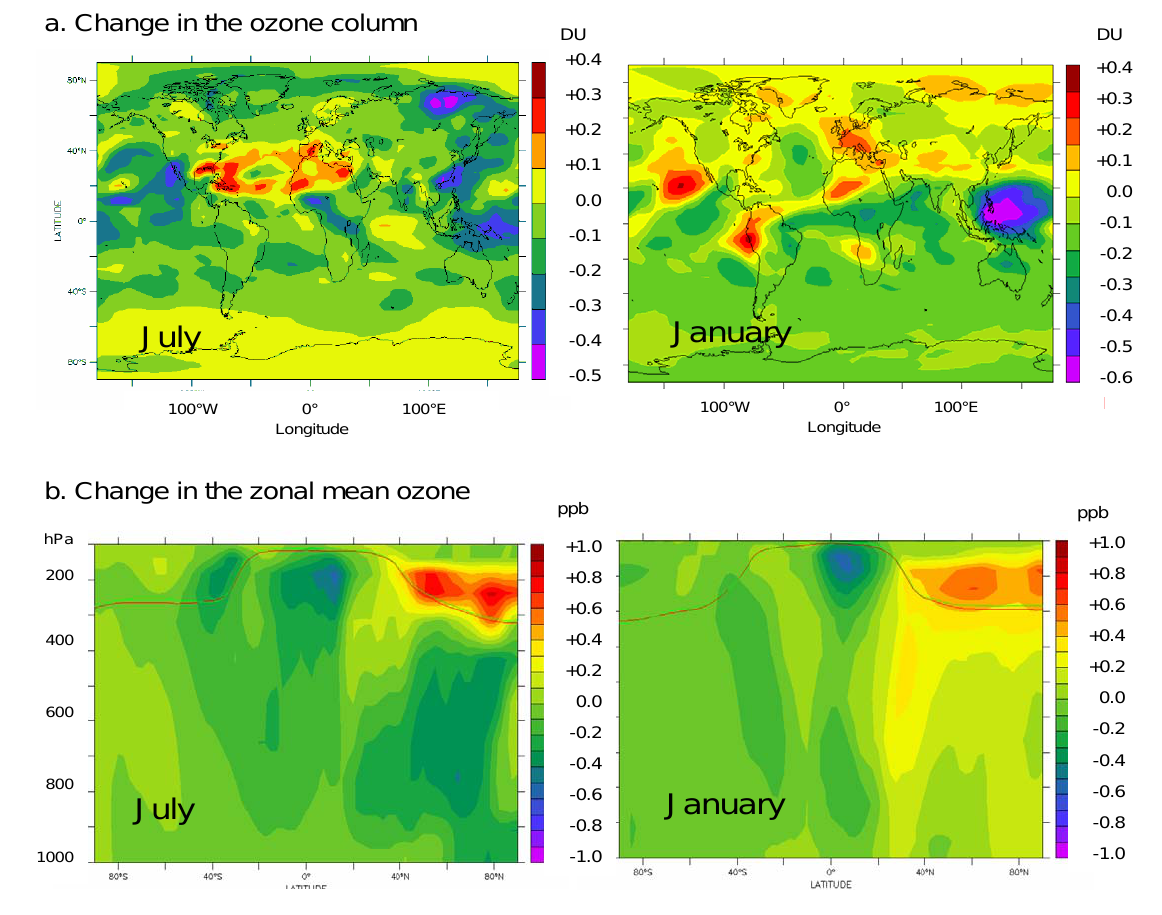
Fig. 11. Effect of future (2050) climate change on the impact of transport emissions on (a) the tropospheric ozone column ( 1 DU) and (b) on zonal mean ozone mixing ratio ( 1 ppb v ) for July (left) and January (right) conditions (A1B